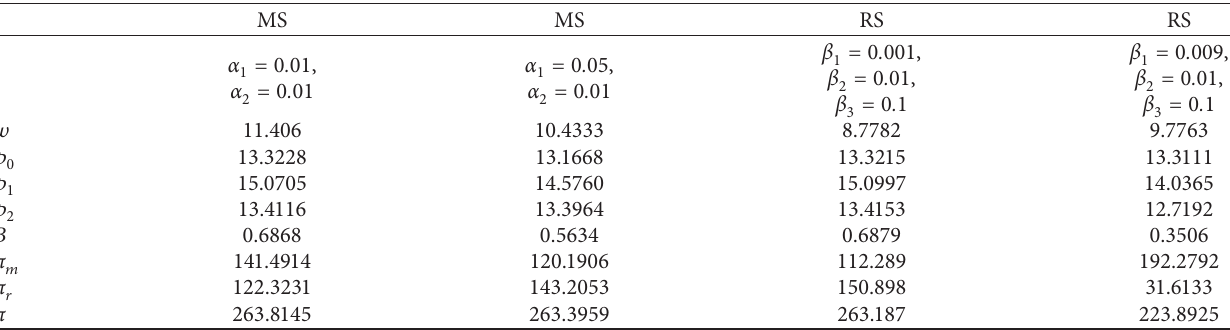
Table 1: Units for magnetic